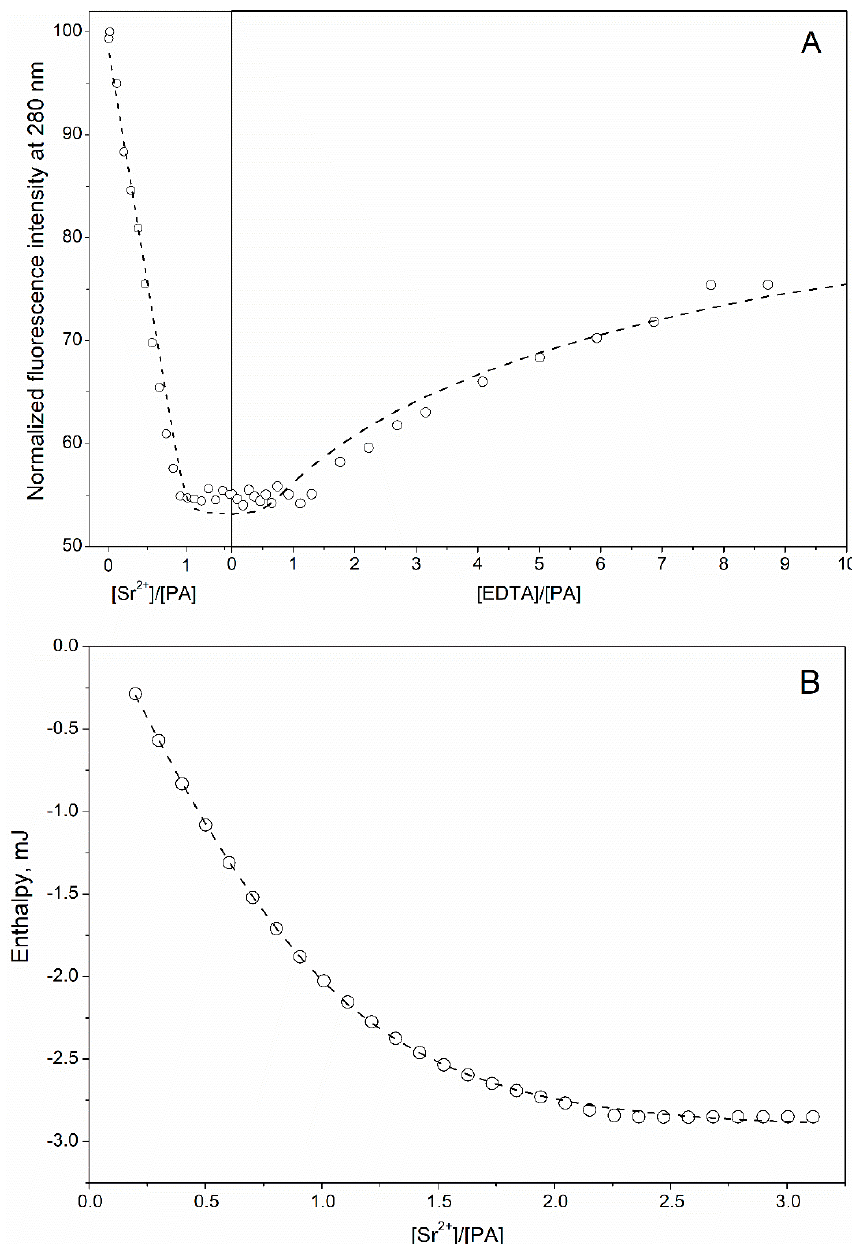
Figure 2. The interaction of Sr 2+ with rWT α -PA at 20 °C, followed by Phe fluorescence ( A ) and ITC ( B ) (10 mM HEPES-KOH pH 8.1). The points are experimental. ( A ) Protein concentration is 19 µM. Fluorescence was excited at 259 nm. The data are approximated by the single site metal binding scheme (3), considering a competition between the protein and EDTA for Sr 2+ (scheme (2)). ( B ) Protein concentration is 97 µM. The curve is a fit according to the sequential metal binding scheme (1).